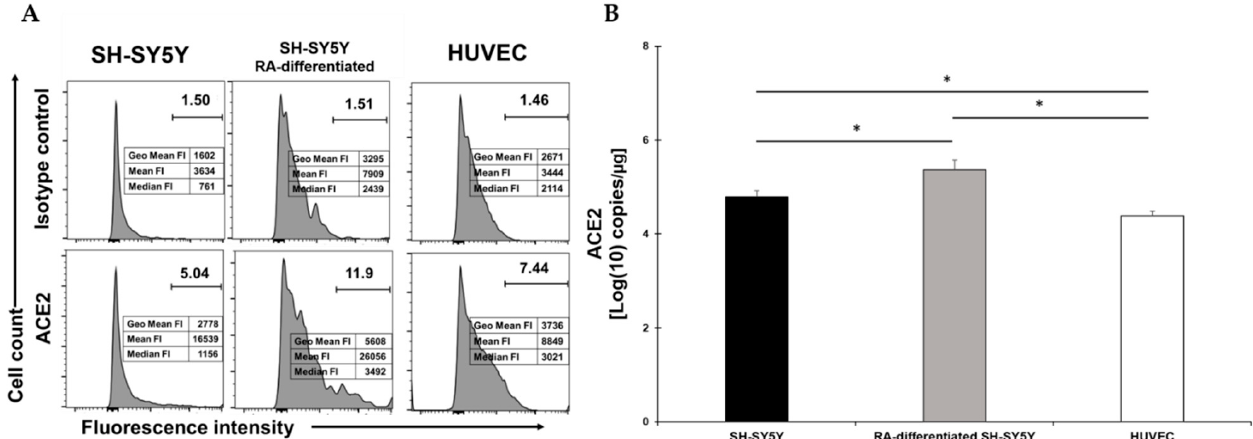
Figure 1. ( A ) Flow cytometry analysis of ACE2 expression in SH-SY5Y (left), RA-differentiated SH-SY5Y (middle), and HUVEC (right) cells. Both SH-SY5Y and HUVEC cells were stained with the specific antibody for the receptor (bottom) or the corresponding isotype control (top). The data related to the fluorescent intensity are also indicated in the figure. A representative of three different experiments is shown. ( B ) mRNA expression levels of ACE2 in both SH-SY5Y and RA-differentiated SH-SY5Y and HUVEC cells. Experiments were done in duplicates. Copy number per µg of mRNA is indicated. * p < 0.05.